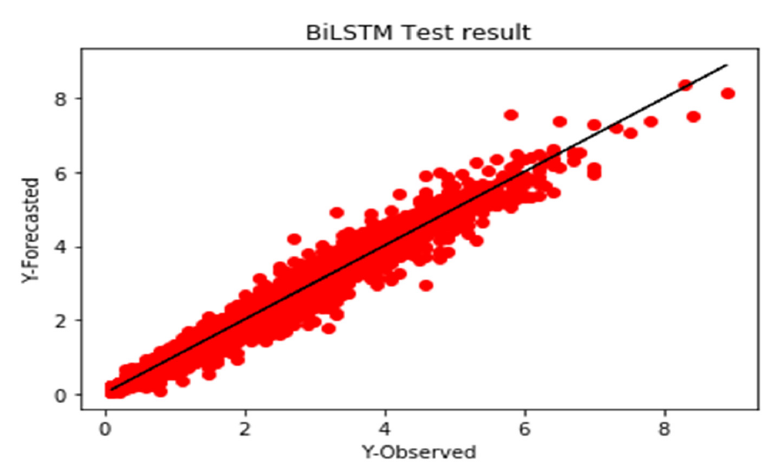
Figure 17. BiLSTM-based wave height model error analysis.